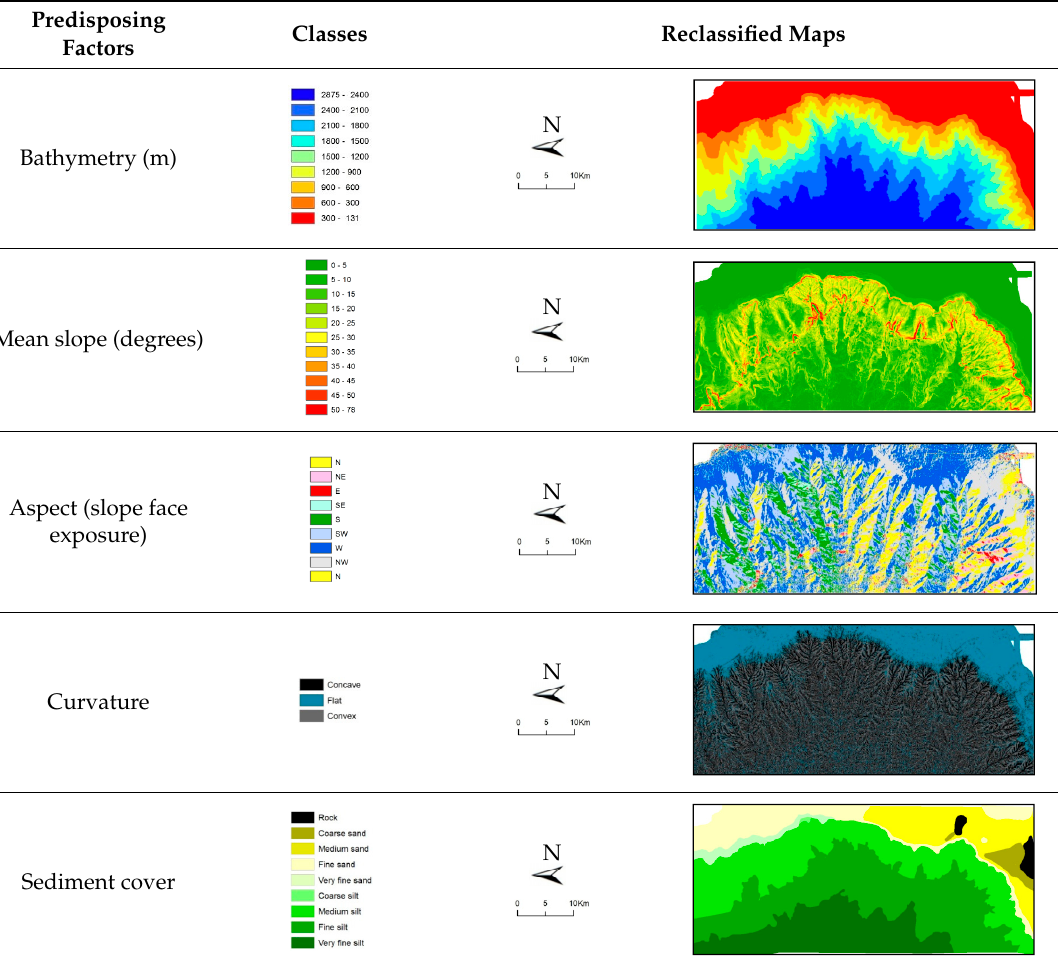
Figure 4. ( A ) Detail of a rotational slide (slump) along the canyon slope in 3D view highlighted with a red line. Black arrow indicates down slope movement. ( B ) NE–SW profile on the canyon slope, transversal to the rotational slide. Location of the P1 profile is in Figure 3.